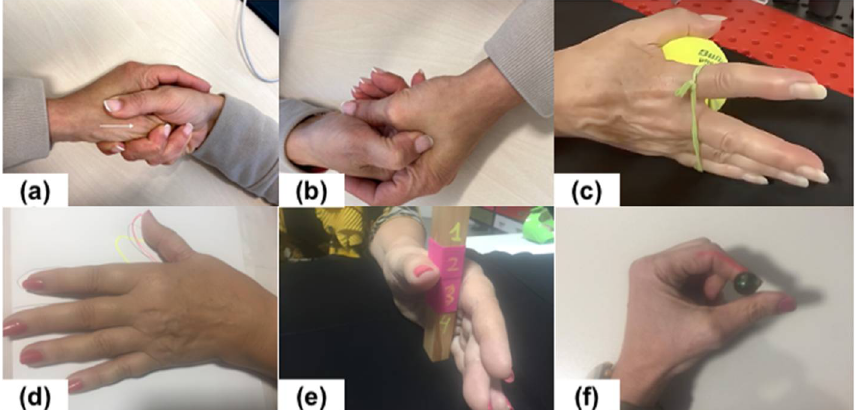
Figure 2. Movement to be reproduced by patients. ( a ) manual distraction of the CMC joint; ( b ) mas- sage of the adductor thumb muscle; ( c ) resistive exercises for the first dorsal interosseous; ( d ) move their thumb to the position as had been previously demonstrated; ( e ) movements of the thumb in different degrees and/or stop at the numbers indicated by the therapist on a stick; ( f ) pass a marble along the radial side of the index finger.